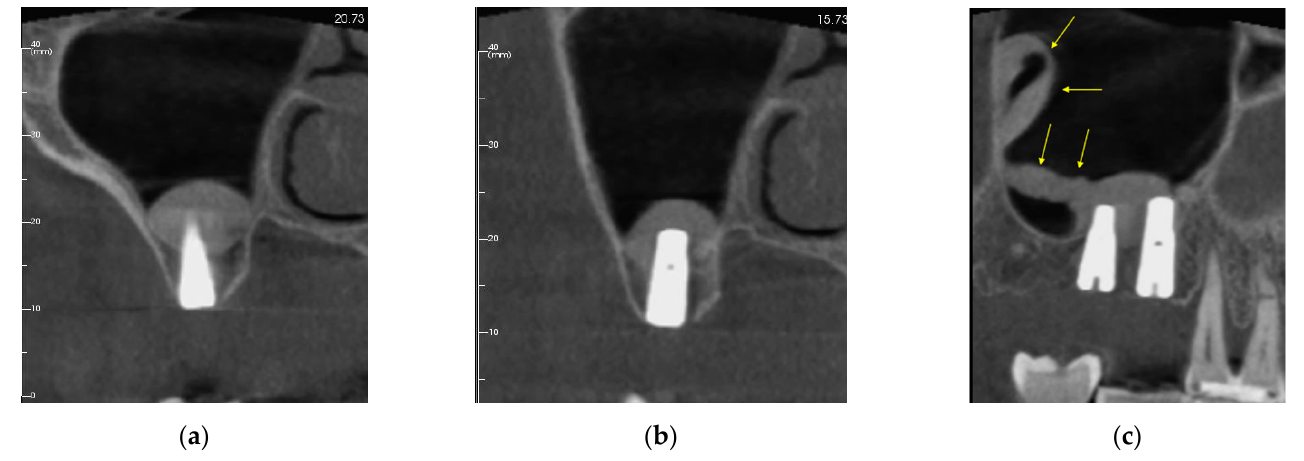
Figure 3. Patient #1. Immediately postoperative CBCT showing: ( a ) and ( b ) cross-section images of the surgical sites with regular “dome-shaped” membrane elevation and graft surrounding both implant apexes; ( c ) Panorex view highlighting a perforation in the distal apical portion of the elevated area, with arrows indicating biomaterial dispersed into the sinus cavity.